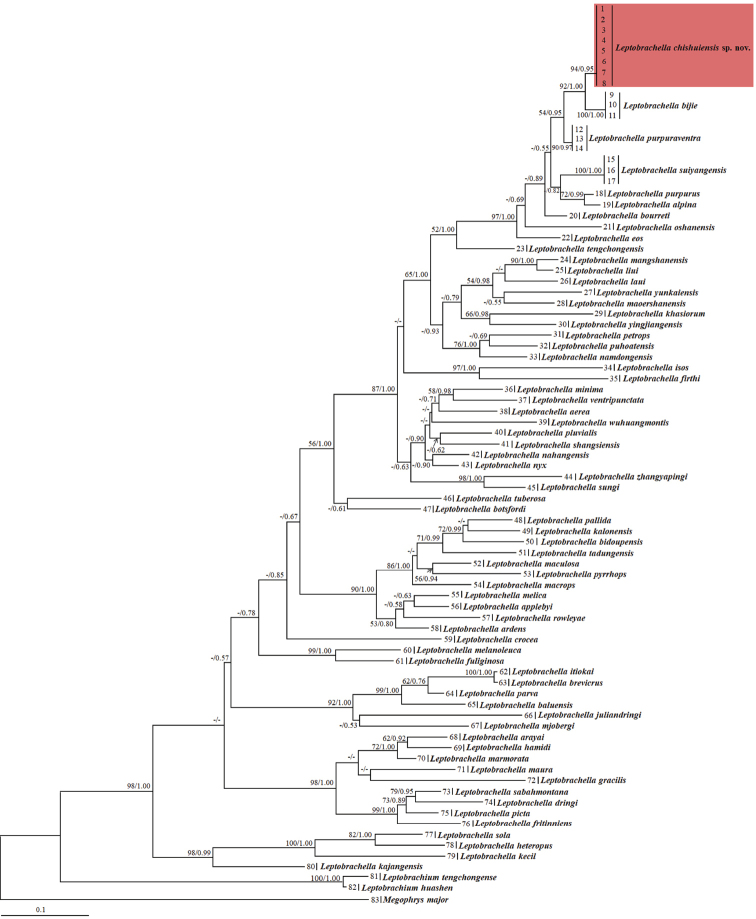
Maximum Likelihood (ML) tree based on the mitochondrial 16S rRNA sequences. Bootstrap supports from ML analyses/Bayesian posterior probabilities from Bayesian Inference (BI) analyses are labelled beside nodes. Information of samples 1–83 refer to Table 1.